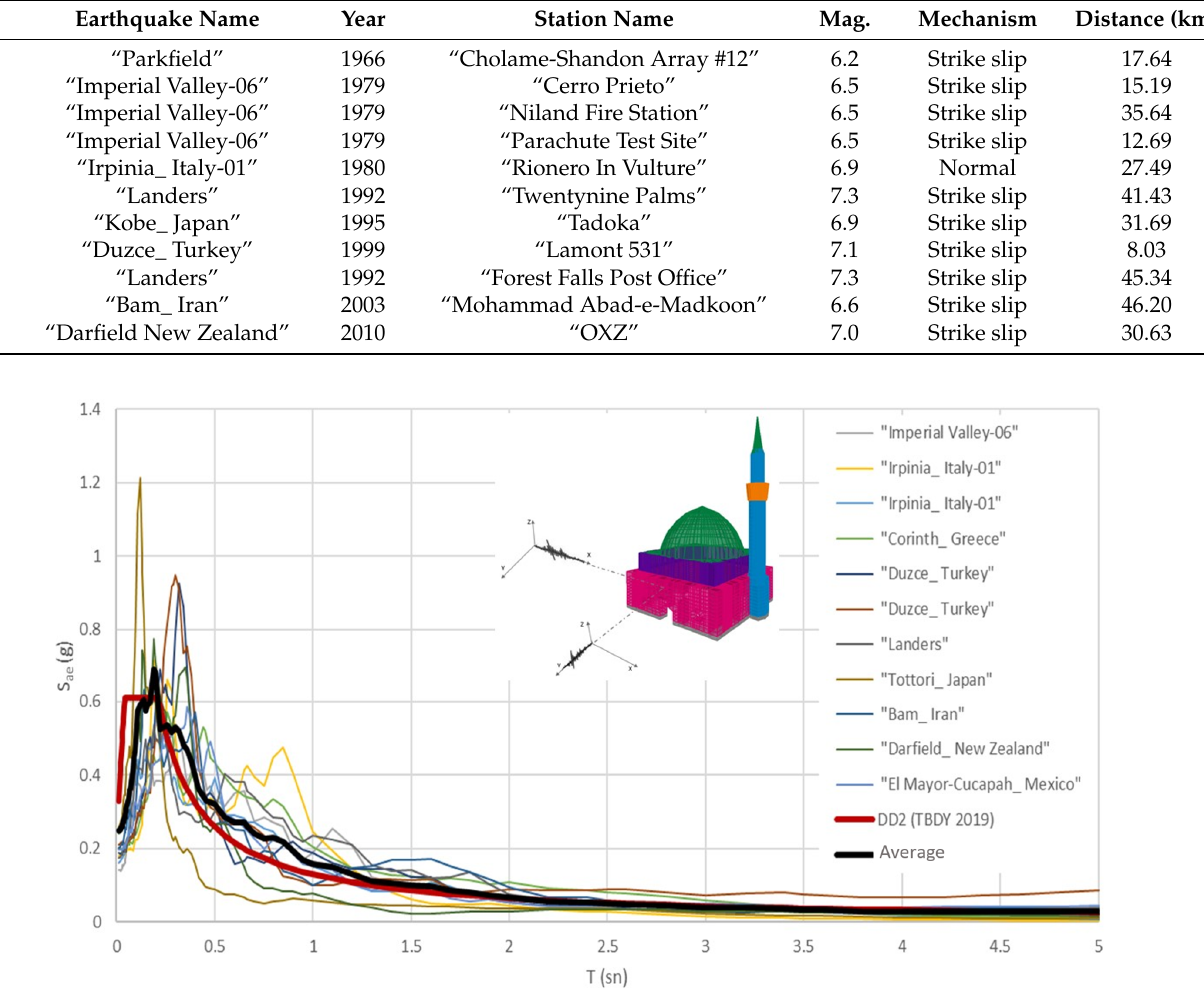
Figure 3. The elastic design acceleration spectrum of earthquake level DD2 used in the earthquake analysis for the historical mosque, the spectra of each earthquake, and the average of these spectra.